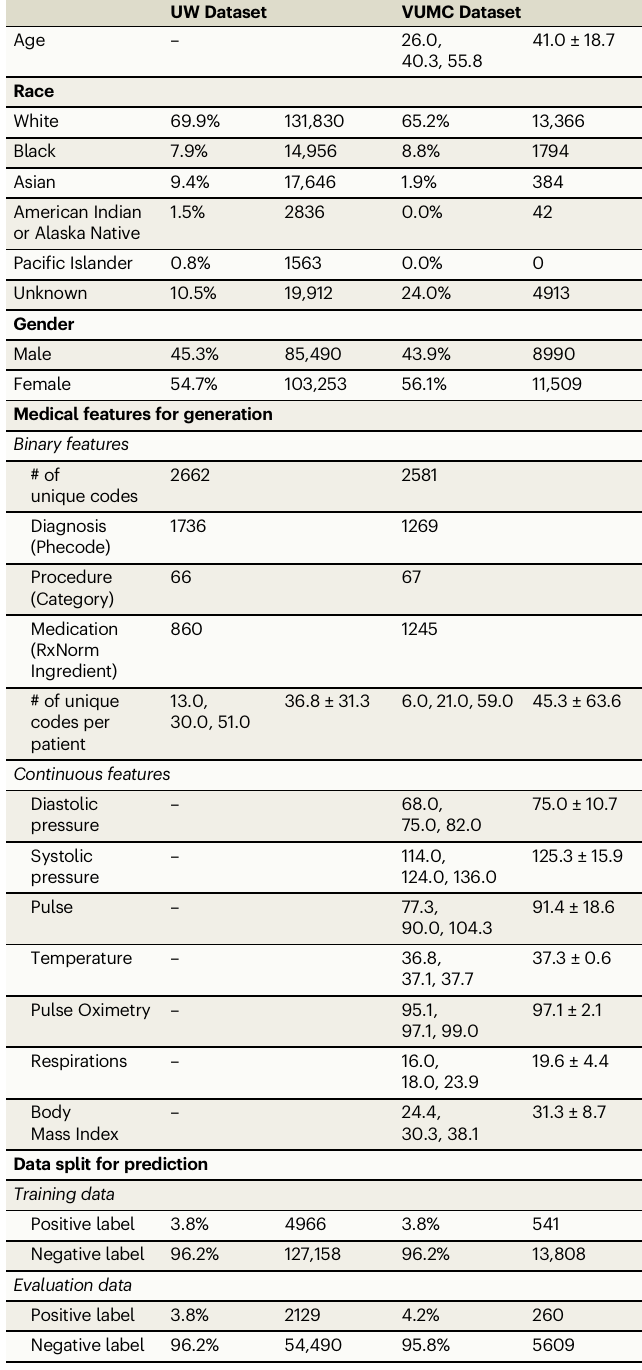
Table 3 | The characteristics of the benchmarking